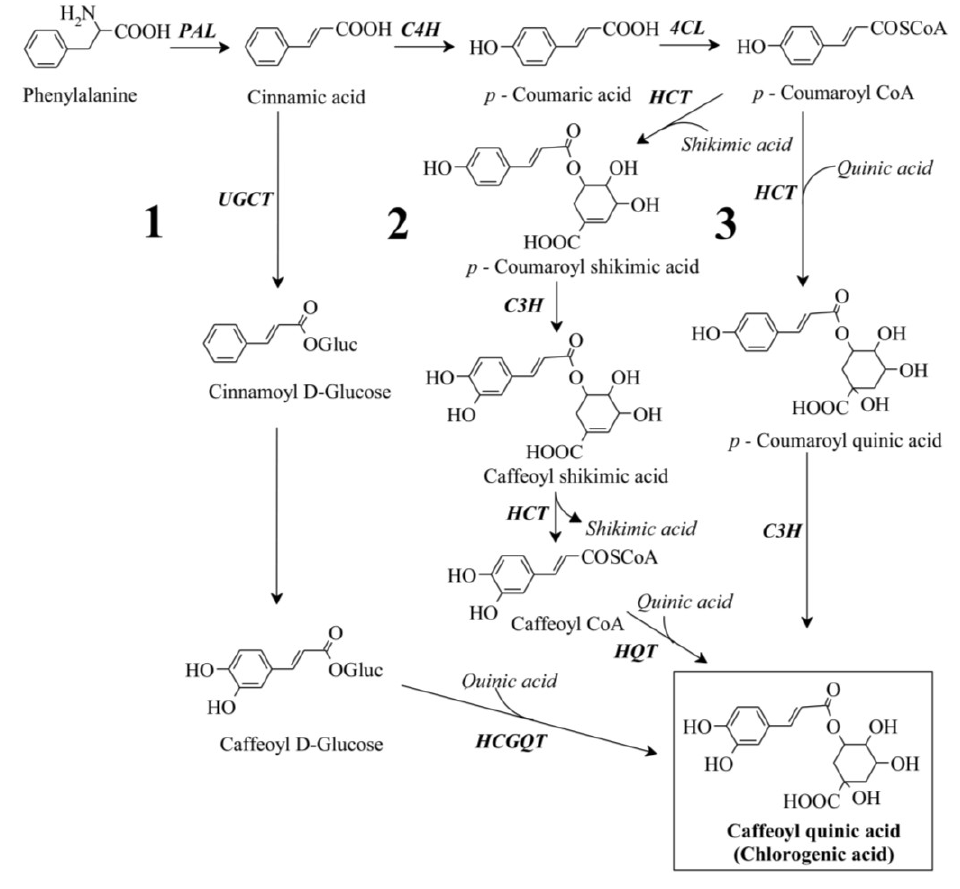
Figure 1. Three proposed pathways for chlorogenic acid synthesis in plants (labeled 1 , 2 and 3 ). PAL, phenylalanine ammonia lyase; C4H, cinnamate 4-hydroxylase; 4CL, 4-coumarate CoA ligase; HCT, hydroxycinnamoyl CoA shikimate/quinate hydroxycinnamoyl transferase; C3H, p- coumarate 3'-hydroxylase; HQT, hydroxycinnamoyl CoA quinate hydroxycinnamoyl transferase; UGCT, UDP glucose: cinnamate glucosyl transferase; HCGQT, hydroxycinnamoyl D -glucose: quinate hydroxycinnamoyl